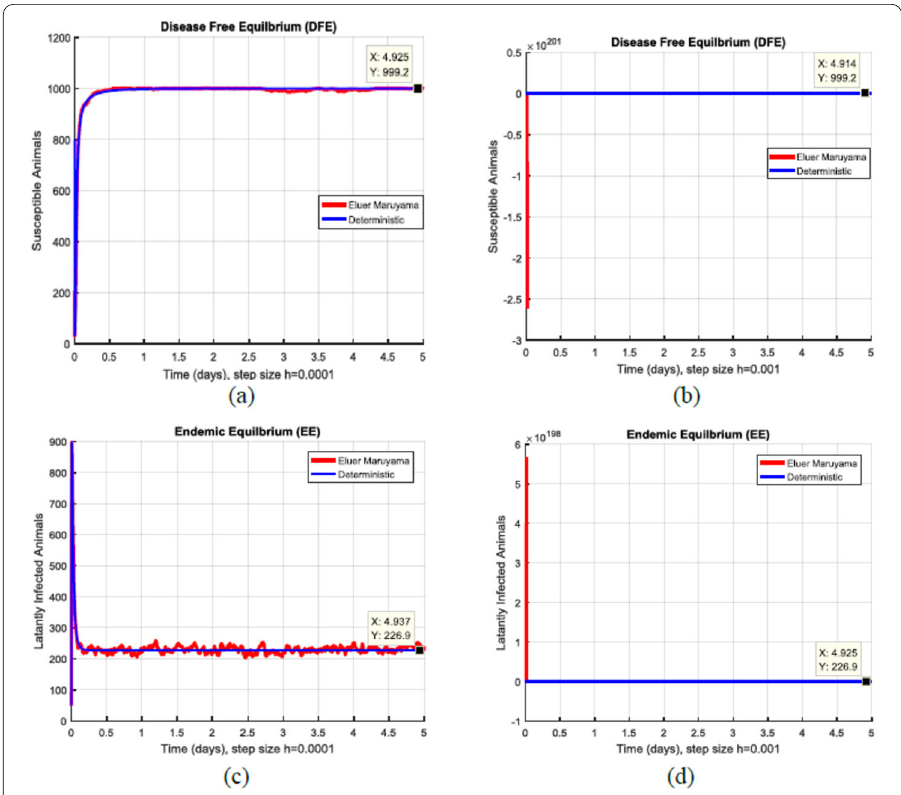
Figure 2 ( a ) Susceptible animals converge to disease free equilibria at h = 0.0001. ( b ) Susceptible animals diverge to disease free equilibria at h = 0.001. ( c ) Infectious animals converge to endemic equilibria at h = 0.0001. ( d ) Infectious animals diverge to endemic equilibria at h =